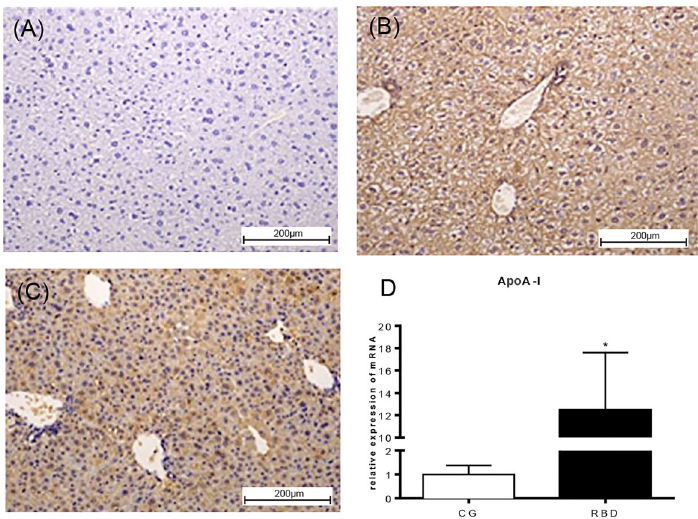
Figure 4. Representative liver ApoA-I immunostaining of the experimental groups, following 40 days of dietary intervention. A , Negative control. B , Nourished (CG) and C , regional basic diet (RBD) groups ( (cid:1) 100, scale bar 200 m m). D , Liver ApoA-I transcriptional level from nourished and RBD-undernourished mice following 40 days of dietary intervention. Data are reported as means ± SE for n=6 per group. *P o 0.05, unpaired Student ’ s t